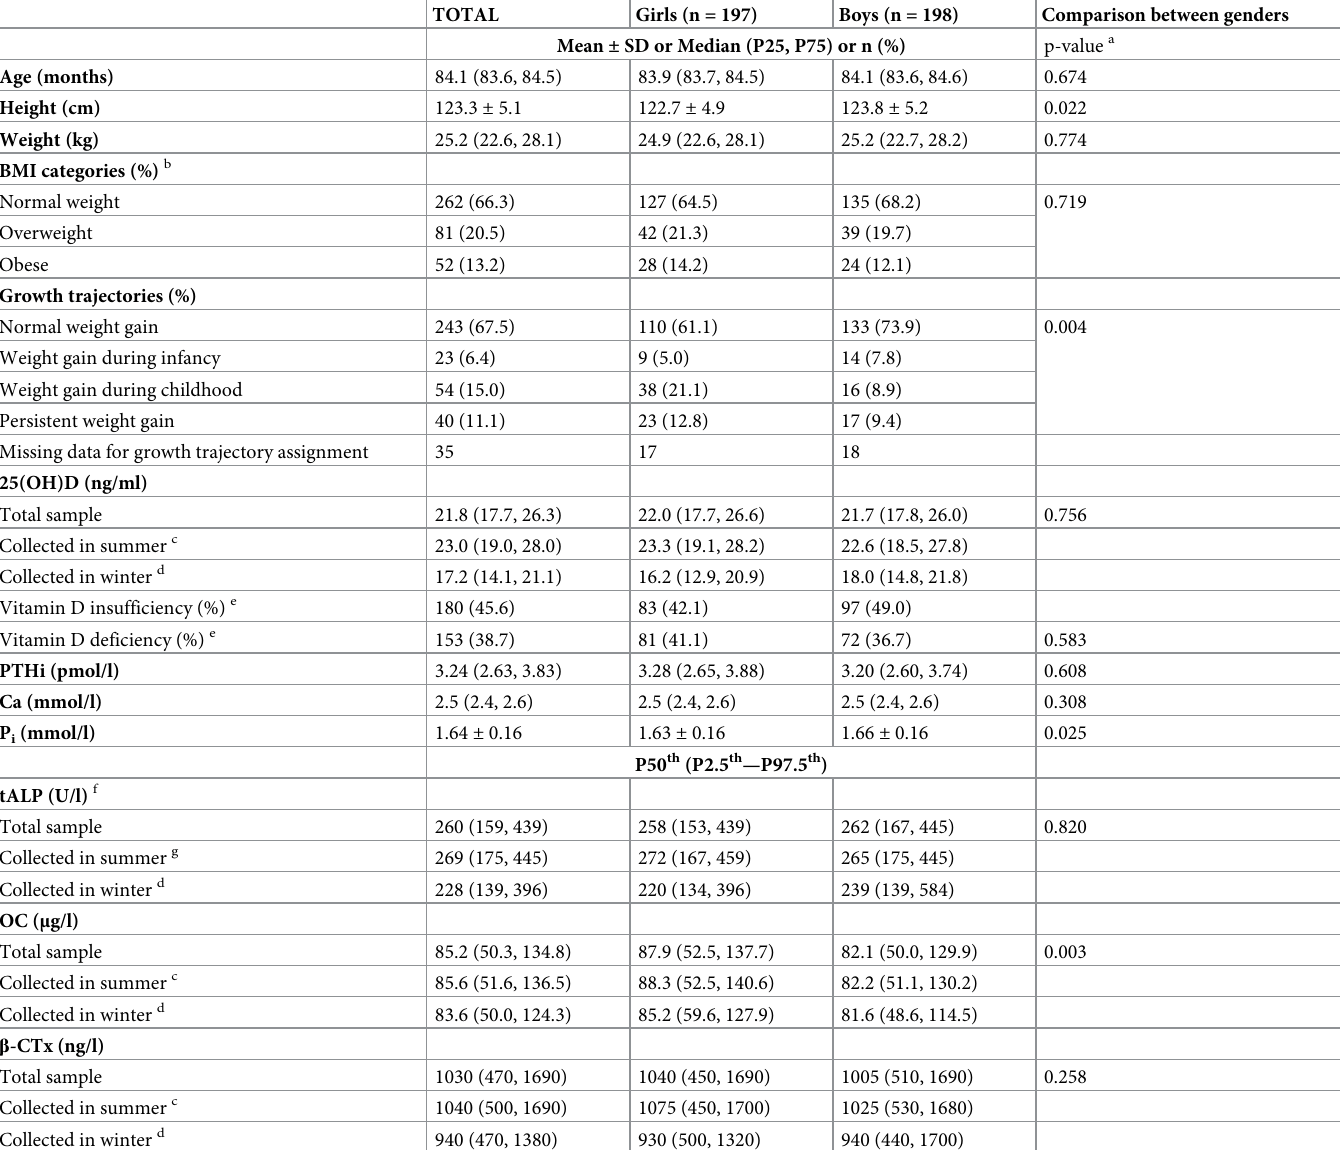
Table 1. Anthropometrics and serum concentrations of vitamin D, parathyroid hormone, calcium, phosphorus and bone metabolism markers, in girls and boys (n =